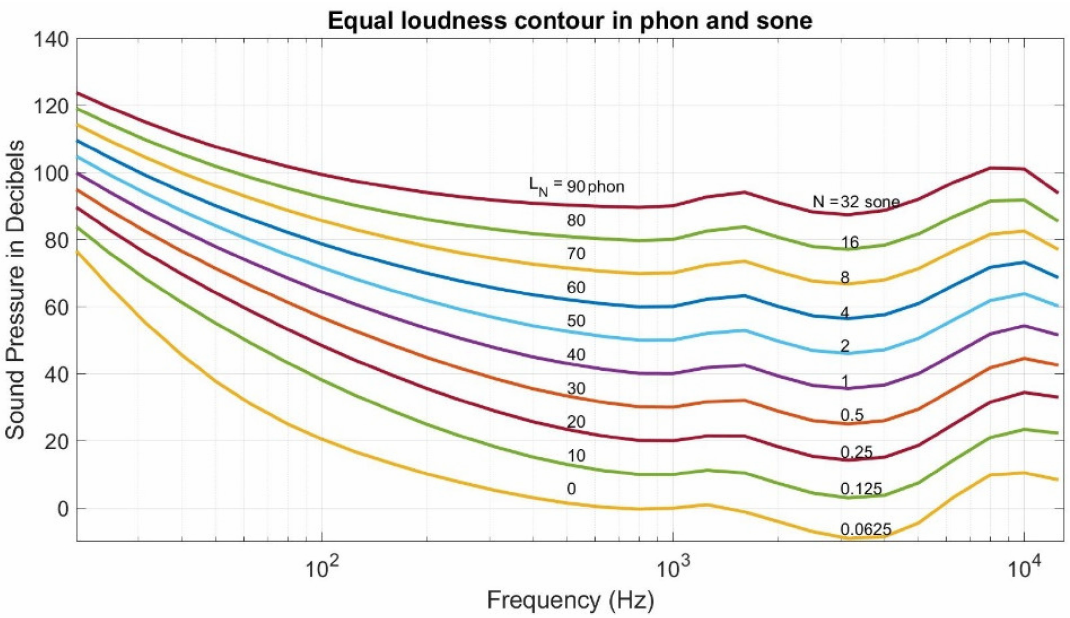
Figure 7. Equal loudness